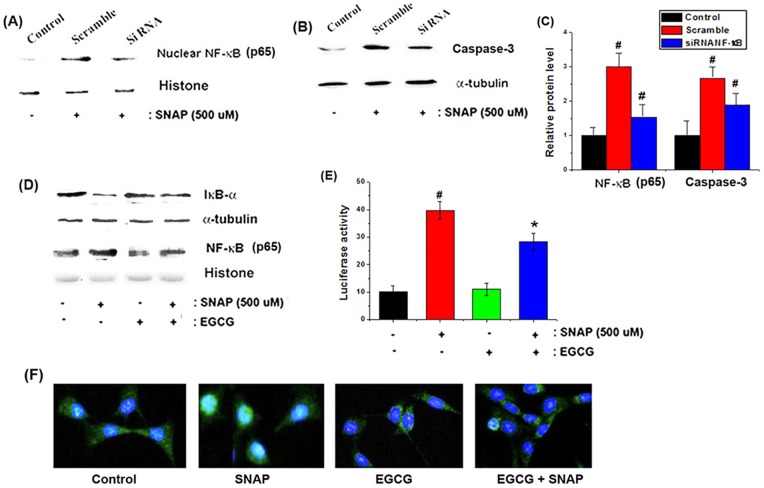
Effects of EGCG on NO-induced NF-κB activation in HEI-COΙ cells.(A) After transfection, cells were treated with 500 μM SNAP for 4 h. After isolation of the nuclear fraction, protein extracts were assayed for NF-κB activity by western blot analysis. (B) Protein extracts were assayed for caspase-3 by western blot analysis. (C) Relative levels of NF-κB and caspase-3 are shown. (D) Cells were pretreated with 50 μM EGCG, followed by treatment with 500 μM SNAP for 4 h. After isolation of cytosolic and nuclear fractions, protein extracts were assayed for IκB-α and NF-κB by western blot analysis. (E) Cells were transfected with an NF-κB-dependent reporter gene for 48 h, and transfected cells were treated with SNAP for 4 h. EGCG (50 μM) was added 2 h prior to SNAP treatment. Cells were harvested, and luciferase activity was measured as described in the Materials and Methods. (F) Cells were fixed and stained with NF-κB (green) and DAPI (blue). Cells were then analyzed using an Olympus microscope (magnification, 100×). All data represent the mean ± SEM of 3 independent experiments (#P<0.05 vs. control, *P<0.05 vs. SNAP alone).